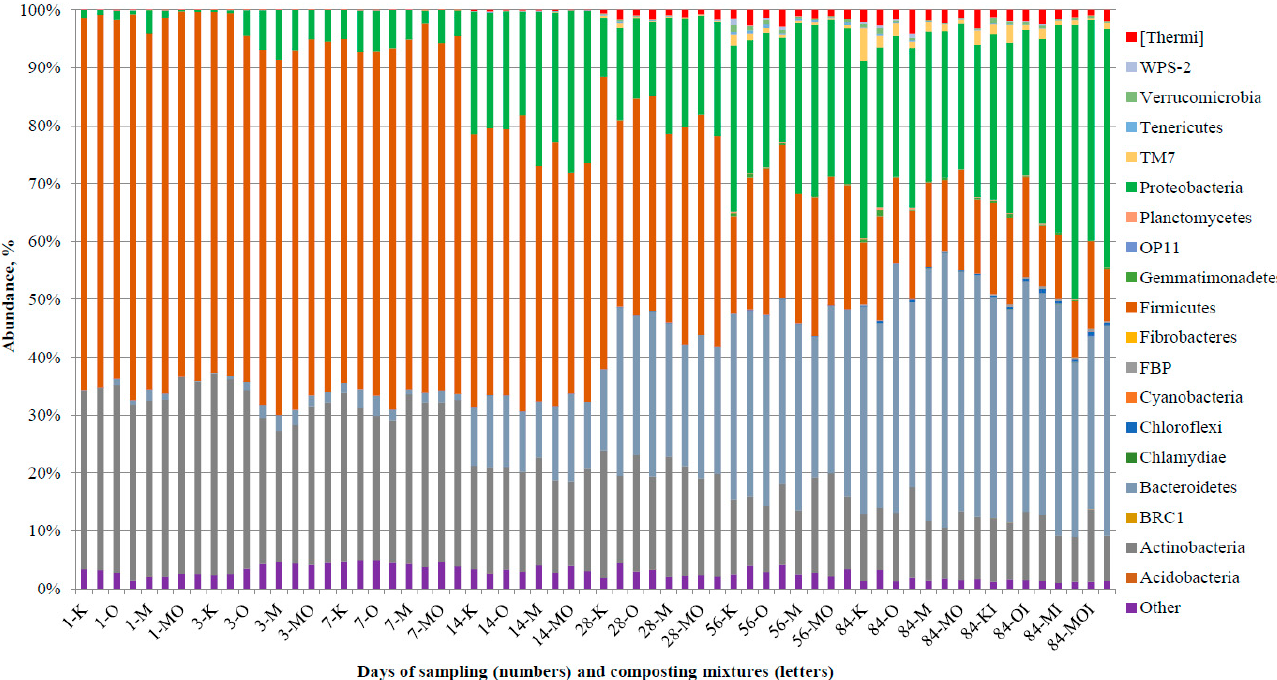
Figure 4. Bacterial community structure of the composting mixtures (phylum level).